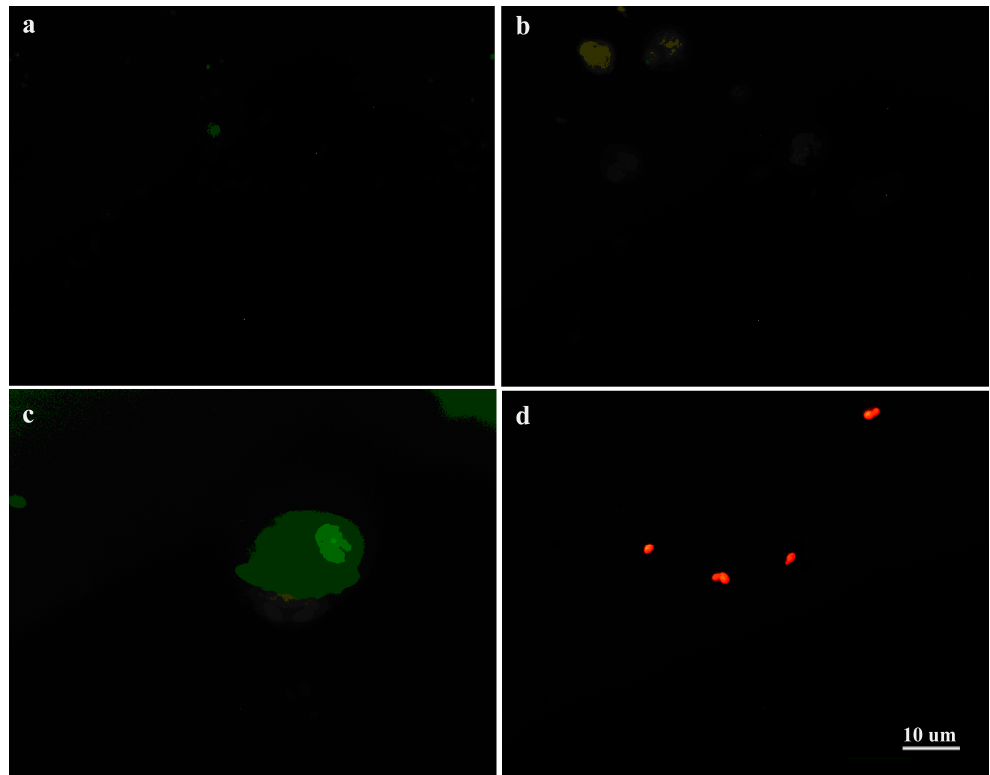
Figure 3. Candida albicans— Macrophage Interactions. Candida albicans cells were untreated or pre-treated with Compound 4 . ( a ) Control macrophage and C. albicans SC5314 cells (live) untreated with Compound 4 were seen in the macrophage’s vicinity; ( b ) Macrophages displaying signs of acidification (red fluorescence), suggesting that SC5314 cells treated with Compound 4 were ingested by them. Yeast cells showing acidification outside macrophages were observed (spotting red fluorescence); ( c ) Macrophages showed acidification (red fluorescence), suggesting that SC5314 cells untreated with Compound 4 were engulfed by it. Live yeast cells attached to macrophages were seen (green fluorescence); ( d ) SC5314 cells pre-treated with Compound 4 emitting red fluorescence.